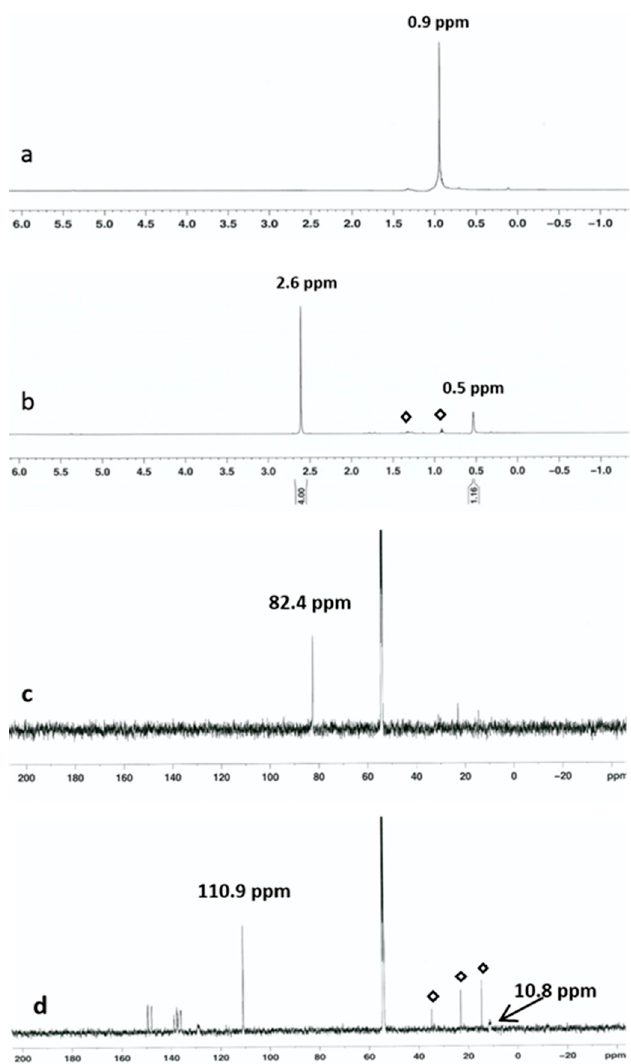
Figure 1. ( a ) 1 H-NMR spectra of TaMe 5 ; ( b ) 1 H-NMR spectra of [TaMe 4 ] + [MeB(C 6 F 5 ) 3 ] − ; ( c ) 13 C-NMR spectrum of TaMe 5 ; ( d ) 13 C-NMR spectrum of [TaMe 4 ] + [MeB(C 6 F 5 ) 3 ] − , (at − 40 °C, peak marked by ( ◊ )